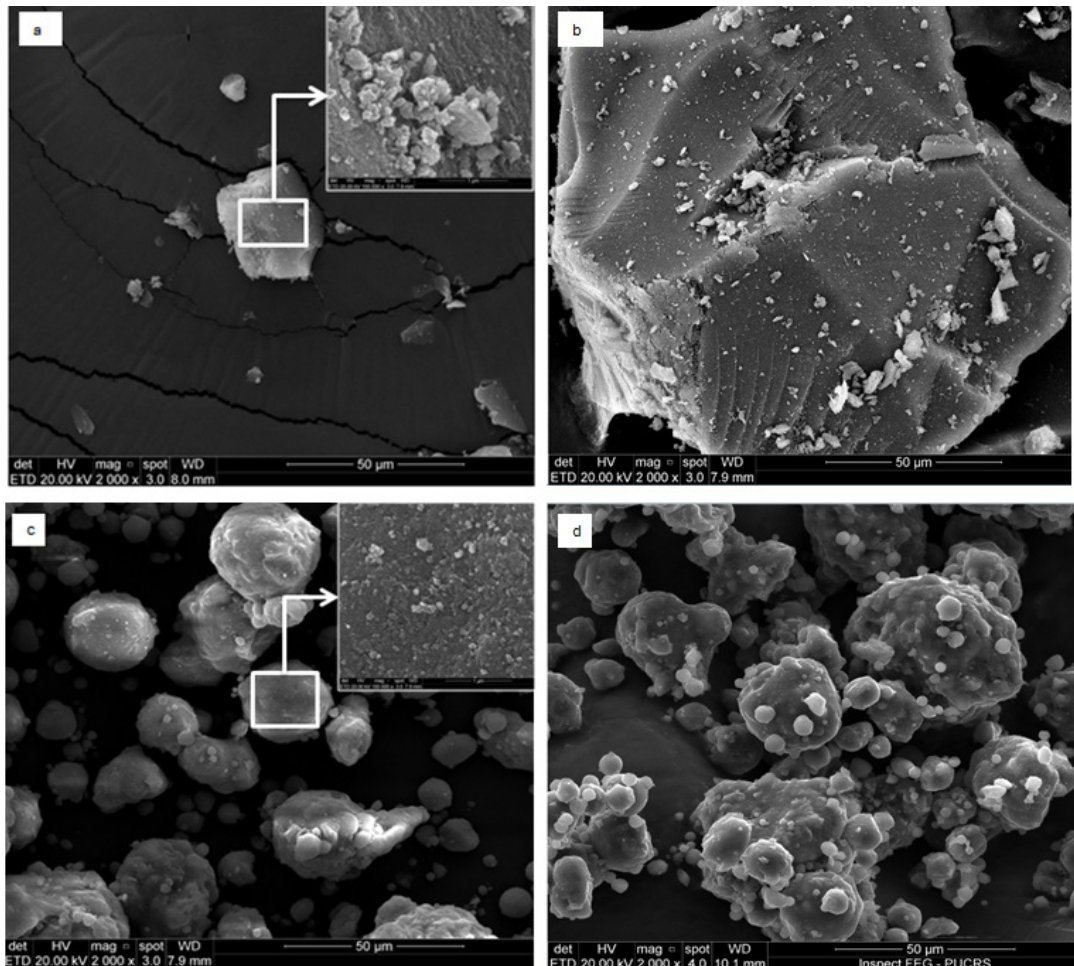
N]-30; (c) A; (d) A-mbmim[Tf 2